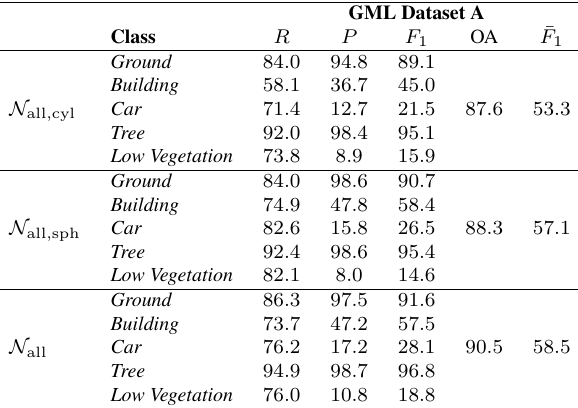
Table 5. Classwise recall ( R ), precision ( P ) and F 1 -score (in %) as well as OA and ¯ F 1 (in %) for the GML Dataset A .